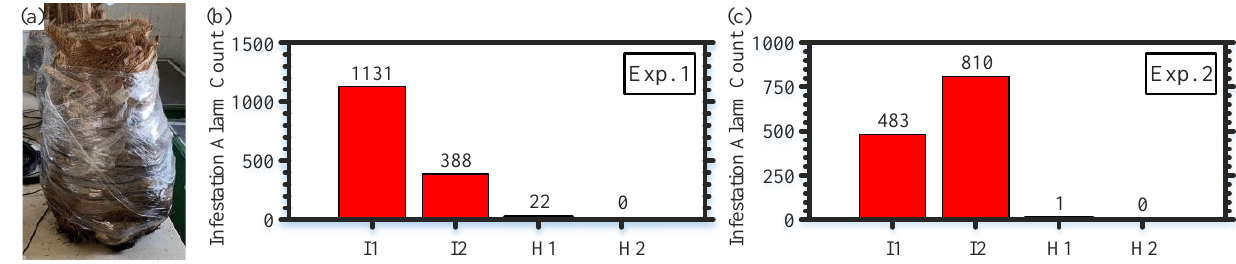
Figure 5. ( a ) Example of a tree used in the controlled environment experiments. Infestation alarm count produced by our sensor during Exp. 1 ( b ) and Exp. 2 ( c ). I: infested tree; H: healthy